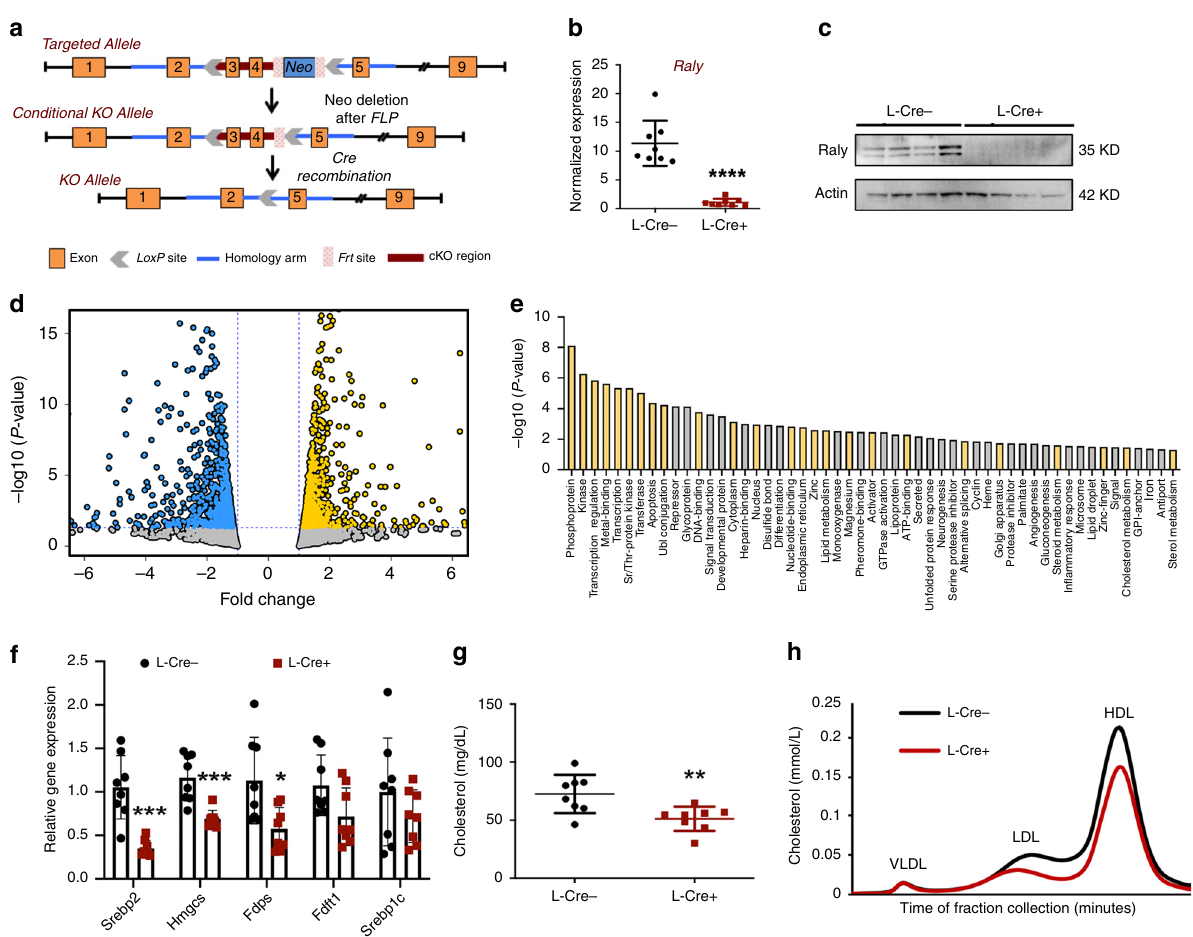
Fig. 1 Loss of RALY reduces Srebp2 and speci fi cally enriches for metabolic pathways. a Schematic of Raly conditional knockout strategy. b Gene expression of RALY in liver from chow-fed mice ( n = 8 per group). c Protein level of RALY in liver from chow-fed mice ( n = 8 per group). d Volcano plot of RNA-seq results from liver with and without RALY ( n = 4 per group). e Enriched functional terms from RNA-seq of differentially regulated genes from mouse liver. Yellow bar indicates functional keyword is also enriched in liver SREBP2 ChIP. f Gene expression in mice liver on chow diet ( n = 8 per group). g Total serum cholesterol levels isolated from chow-fed mice ( n = 8 per group). h Cholesterol levels in pooled fractionated serum from mice in g . All data are mean ± SD. * P < 0.05; ** P < 0.01, and *** P < 0.001, using two-tailed Student ’ s t